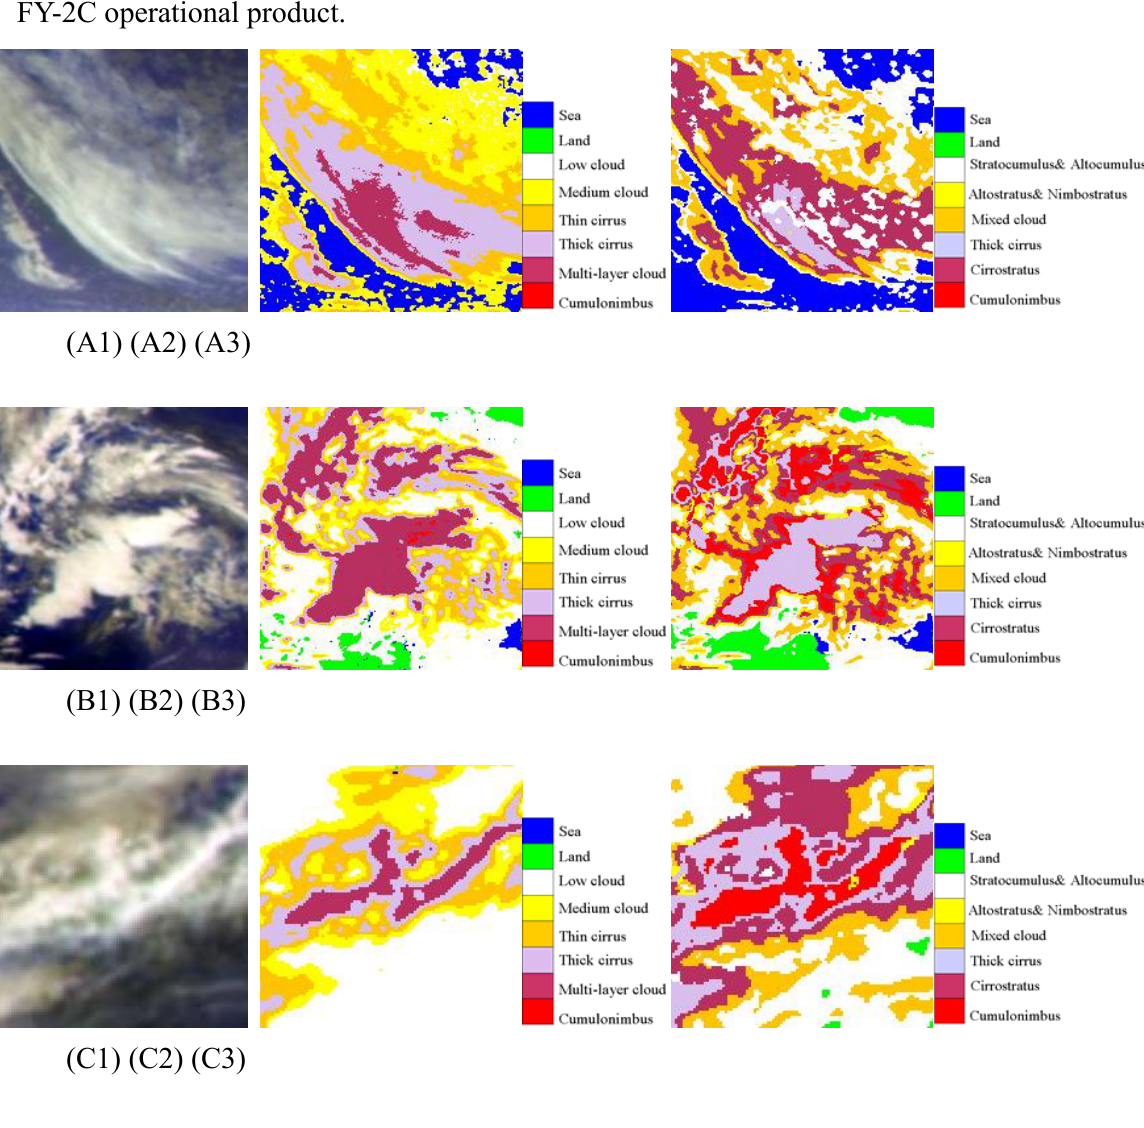
second line (B1, B2, B3) are cirrus cases at 15: 00 UTC (night); (C) the third line (C1, C2, C3) are cirrus cases at 23: 00 UTC (twilight); The first column (A1, B1, C1) are pseudo-color composite map of Tbb of IR1, IR2 and WV; The second column (A2, B2, C2) are cloud classification results of ANN; The third column (A3, B3, C3) are results of